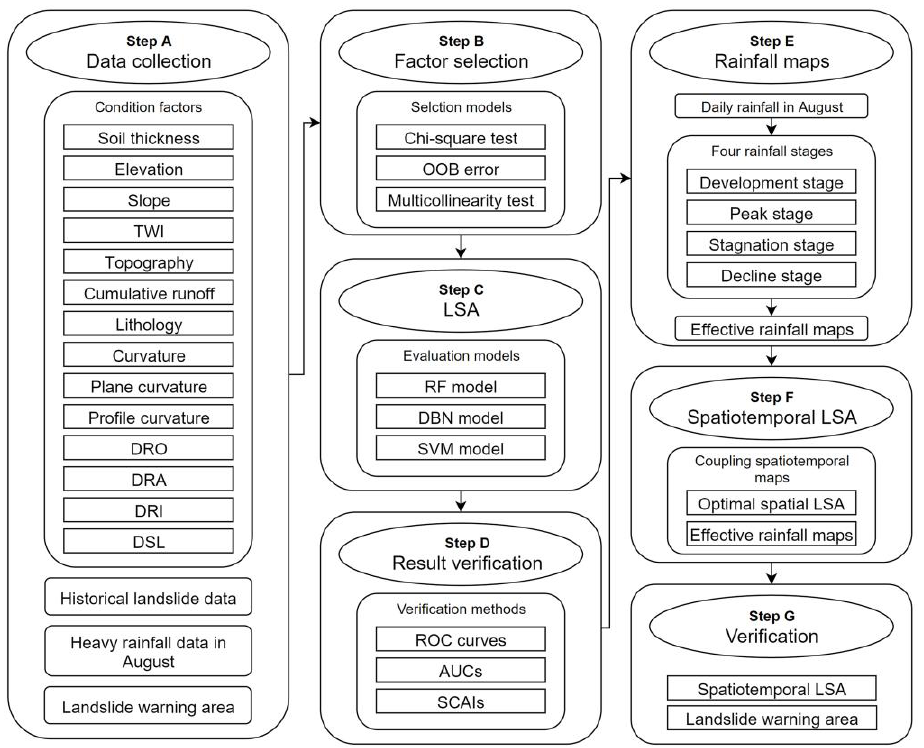
Figure 1. Schematic flowchart representing the methodology.